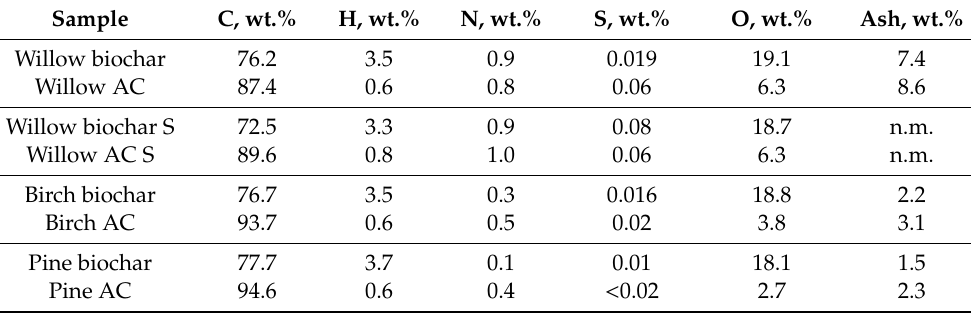
Table 1. The elemental and ash results of the unwashed biochars and ACs. Sample C,